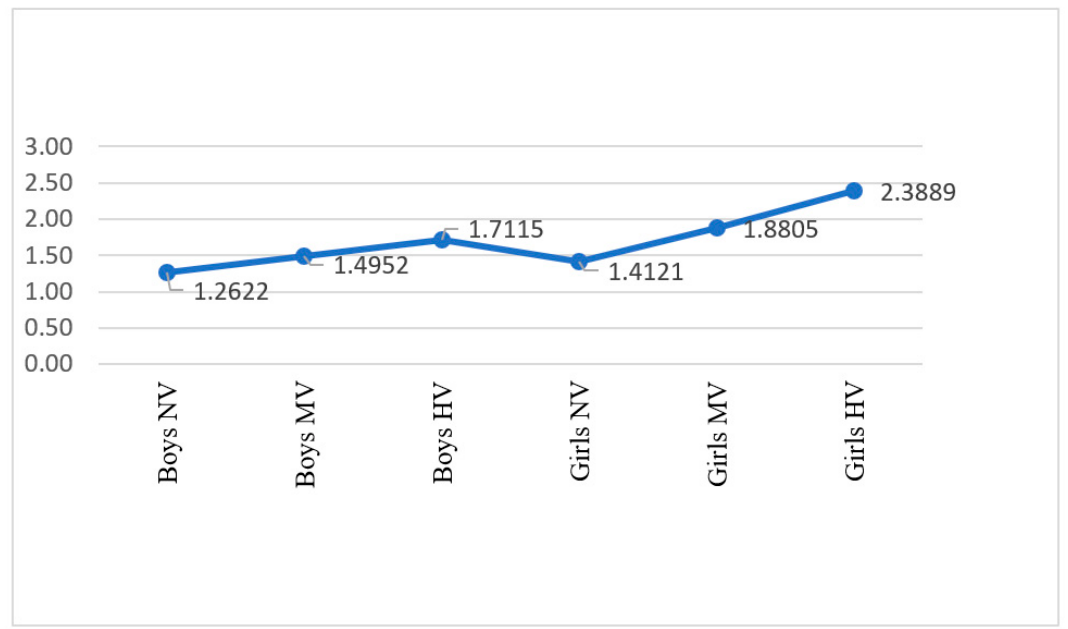
Figure 2. Marginal means of suicidal ideation and gender. Note: NV: no victimization, MV: moderate victimization, HV: high victimization.